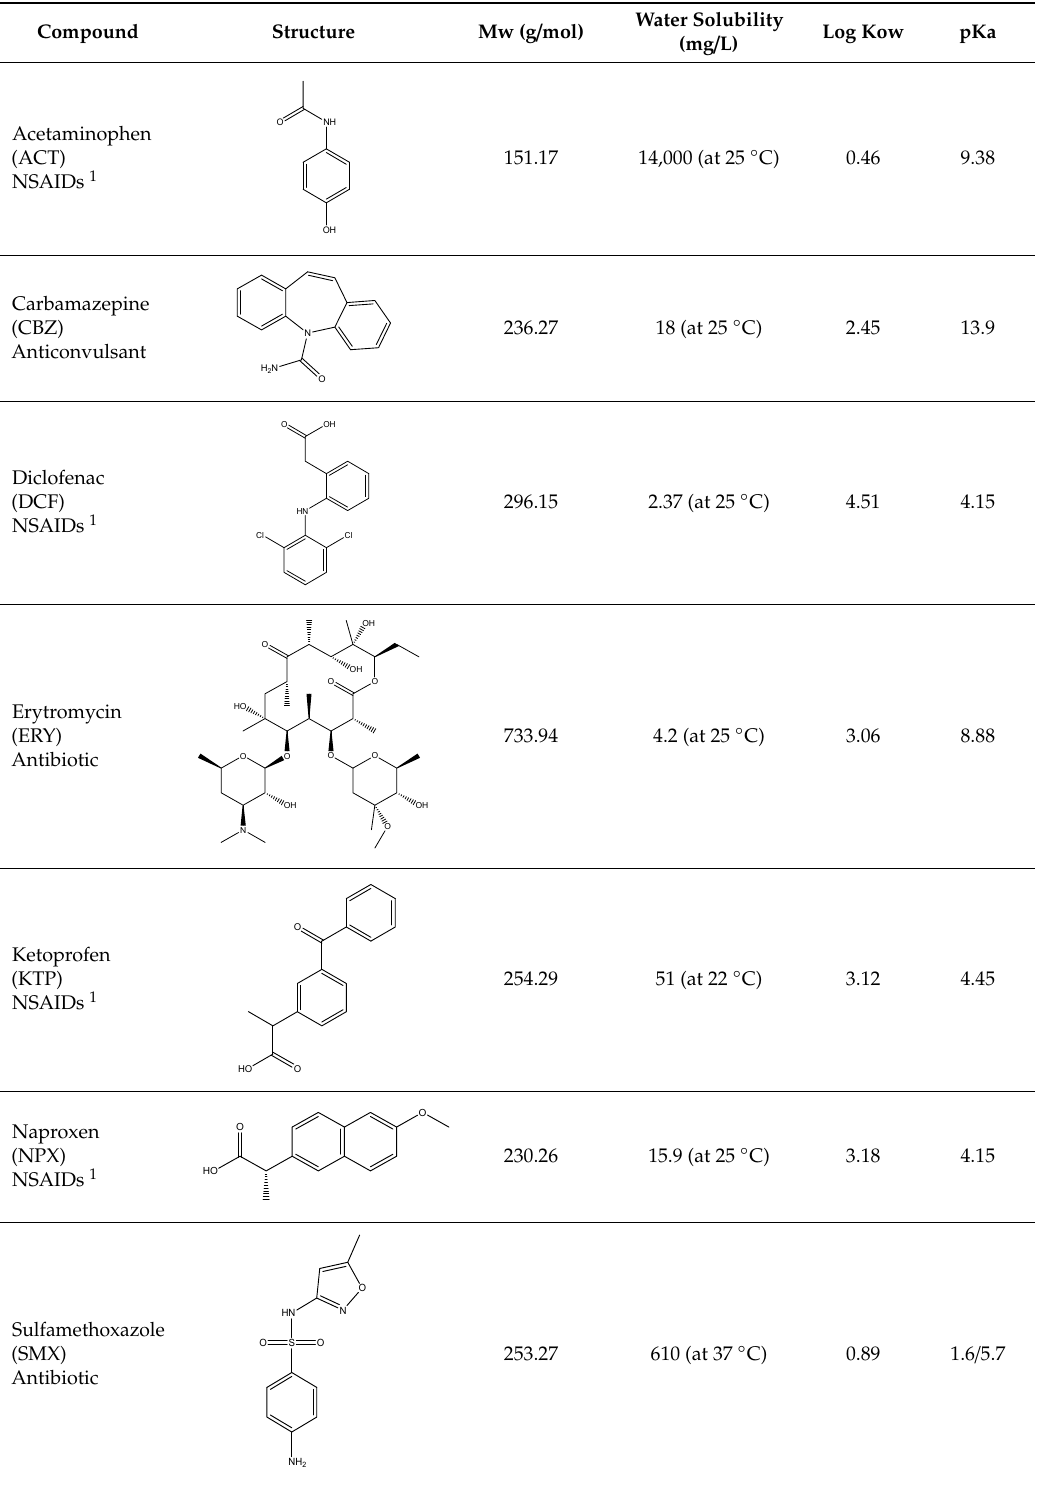
Table 1. Physico-chemical properties and chemical structure of selected contaminants of emerging concern (CECs).